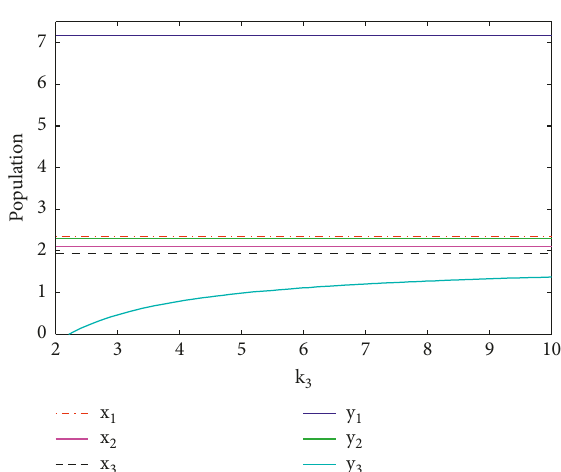
Figure 14: Variation of the system (1) with respect to k